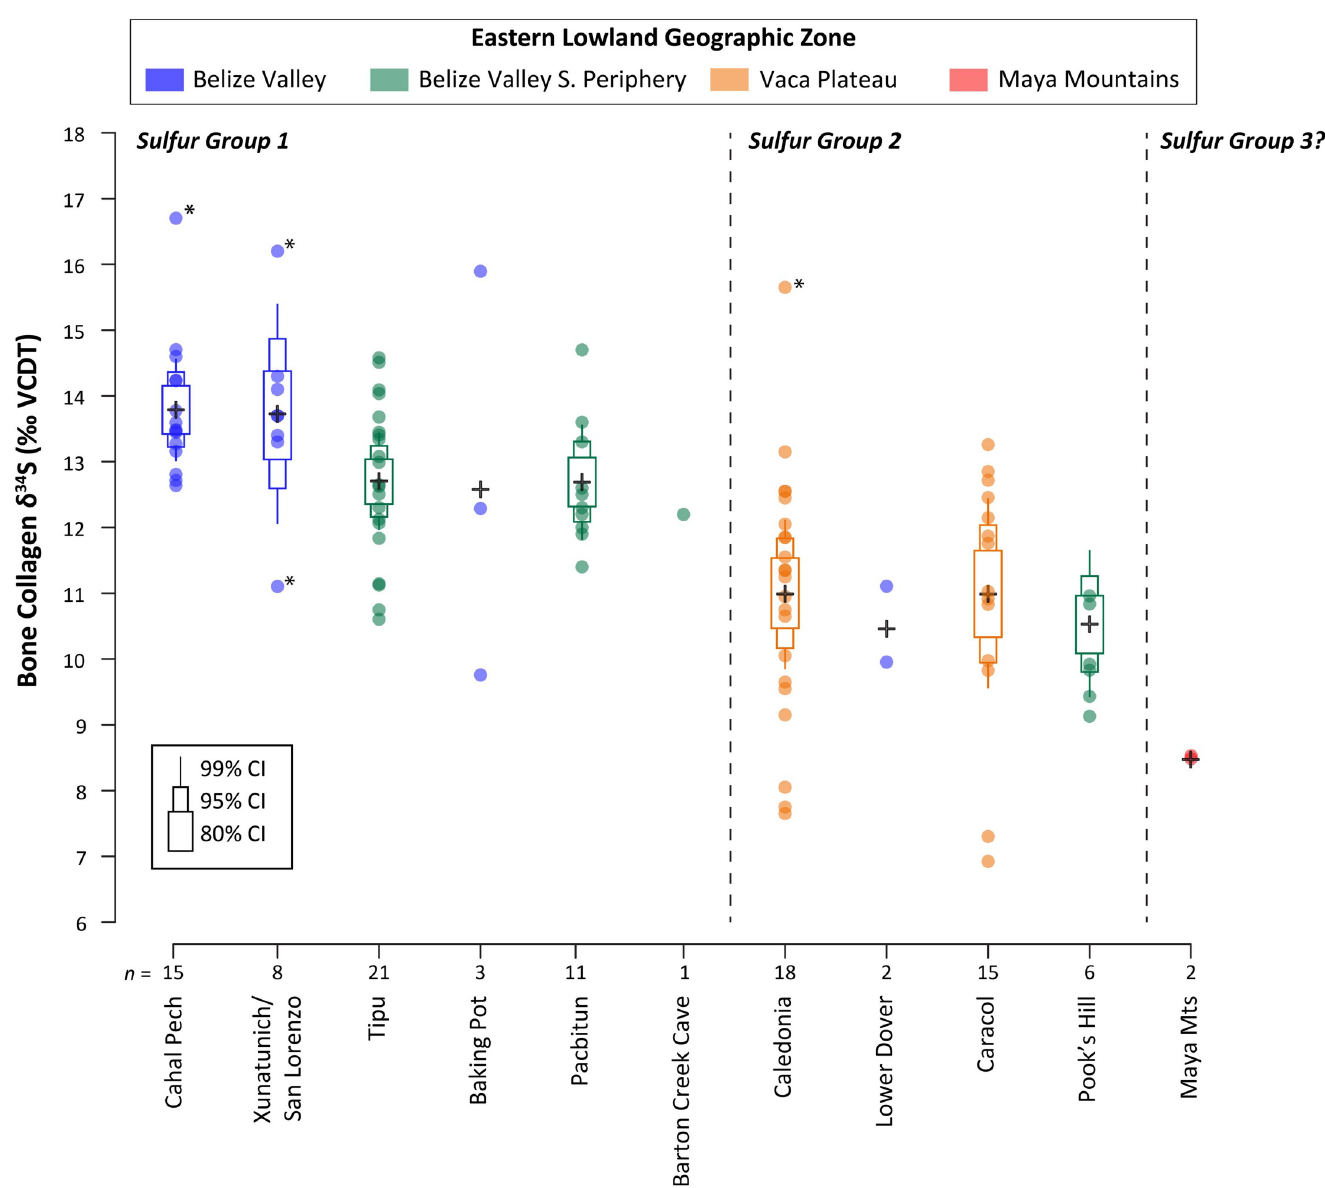
Fig 5. Plot of the mean δ 34 S values by site and sulfur group. Data points are shown as circles with the means for each context indicated by a cross. The bullet graph shows the 80%, 95%, and 99% confidence intervals (CIs; thickest to thinnest bullets) around the mean (cross). Statistical outliers indicated by a star. a mean value of +10.7 ± 2.6 ‰. This broad range is partly driven by outliers but may also result from different geographic zones within Group 2, the use of isotopically distinct catchment zones at sites like Caledonia [156], or sulfate inputs from streams and rivers draining from the Maya Mountains through different geological zones. A third possible group with mean values that fall outside of the 99% confidence interval around the means of the other two groups con- sists of the two Mountain Pine Ridge individuals who exhibited the same low δ 34 S value (+8.5 ‰), possibly indicating a smaller and lower range of values for individuals from the Maya Mountains. Significant temporal differences are also noted in the δ 34 S values. These changes,